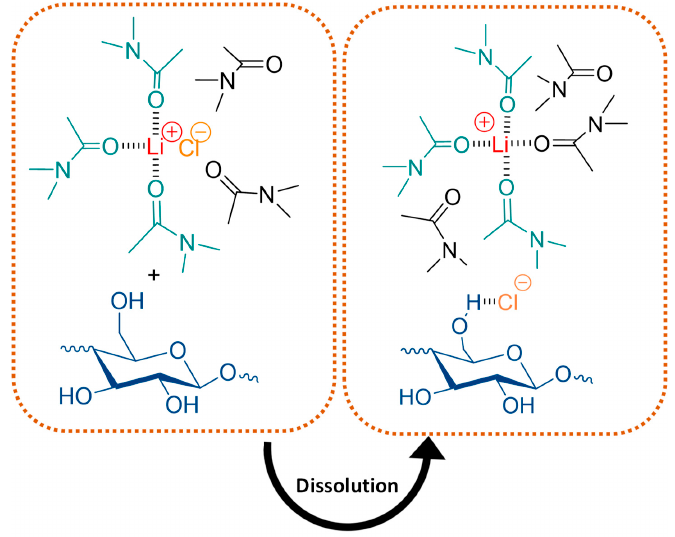
Figure 5. Schematic representation of the interactions among Li + cation, Cl − anion and DMAc when cellulose dissolves into the DMAc/LiCl system. Adapted from [122].